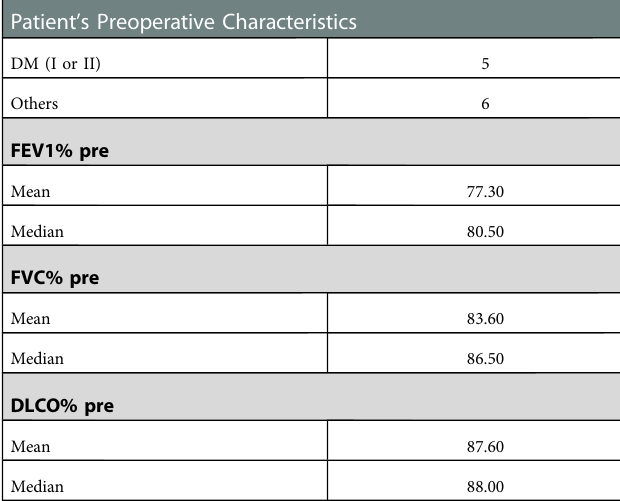
was 8.6 h. The global mean value of length of hospitalization and maintenance of the chest tube were respectively 3.5 and 2.0 days ( Table 3 ). We did not register 30-days post-operative mortality.